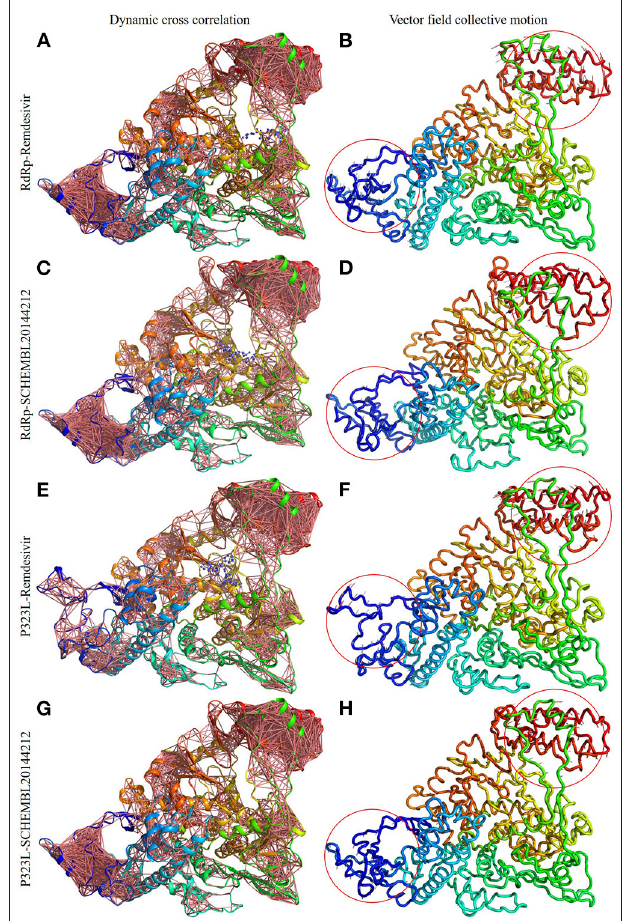
FIGURE 3 | Dynamic cross-correlation networks and vector field collective motions of docked complexes. Depiction of cross-correlation networks: (A) RdRp-Remdesivir; (C) RdRp-SCHEMBL20144212; (E) P323L-Remdesivir; (G) P323L-SCHEMBL20144212. Depiction of vector field collective motions: (B) RdRp-Remdesivir; (D) RdRp-SCHEMBL20144212; (F) P323L-Remdesivir; (H) P323L-SCHEMBL20144212. Red circles indicate differences in the direction of collective motions by